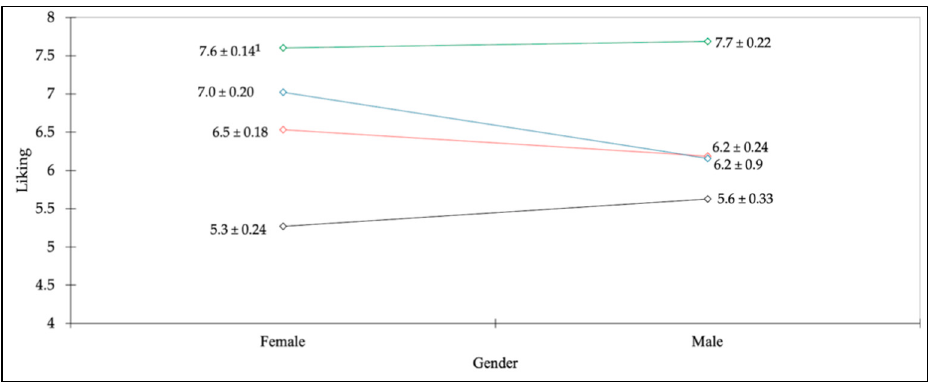
Figure 2. 1 The mean overall liking scores (±standard error) of each ice cream between female and male participants. Green indicates sucrose ice cream; blue indicates Reb M ice cream; red indicates Reb D ice cream; black indicates Reb A ice cream.